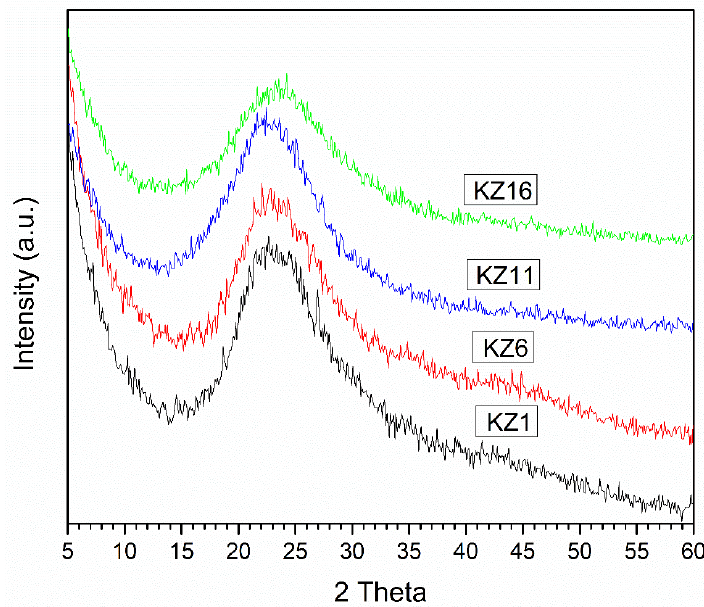
Figure 6. XRD diagram of silica-based solid synthesized.